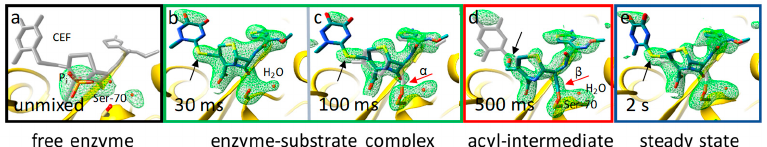
Figure 6. Active site structures during the BlaC reaction with CEF [64] as determined by MISC. Simulated annealing ‘omit’ difference density shown in green on the 2.5 σ level. ( a ) Catalytic cleft of the free enzyme, phosphate (P i ), and water is present. Ser-70 is marked. The position of CEF is shown in gray as a guide to the eye. ( b ) Catalytic cleft 30 ms after mixing; resolution 2.75 Å. Strong electron density shows the CEF ligand. ( c ) Catalytic cleft 100 ms after mixing; resolution 2.15 Å. Gap in electron density (red arrow, α ) shows that the covalent bond has not yet formed. Black arrows in ( b ) and ( c ) point to the sulfur of the leaving group. ( d ) Catalytic cleft 500 ms after mixing; resolution 2.2 Å. The gap between the CEF and Ser-70 is closed, indicating a covalent bond (red arrow, β ). The sulfur feature (black arrow, behind the hydroxyl) is gone. ( e ) Catalytic cleft in the steady state. Similarities to the 30 ‐ ms and 100 ‐ ms time delays are evident.